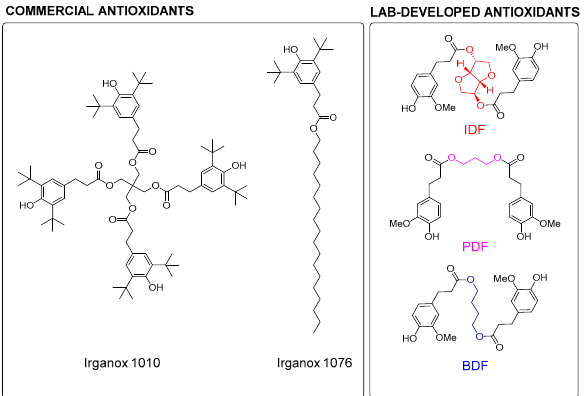
Figure 6. Developed structures of phenolic additives. Table 1. Hildebrand solubility parameters (HiSP) of phenolic antioxidants.